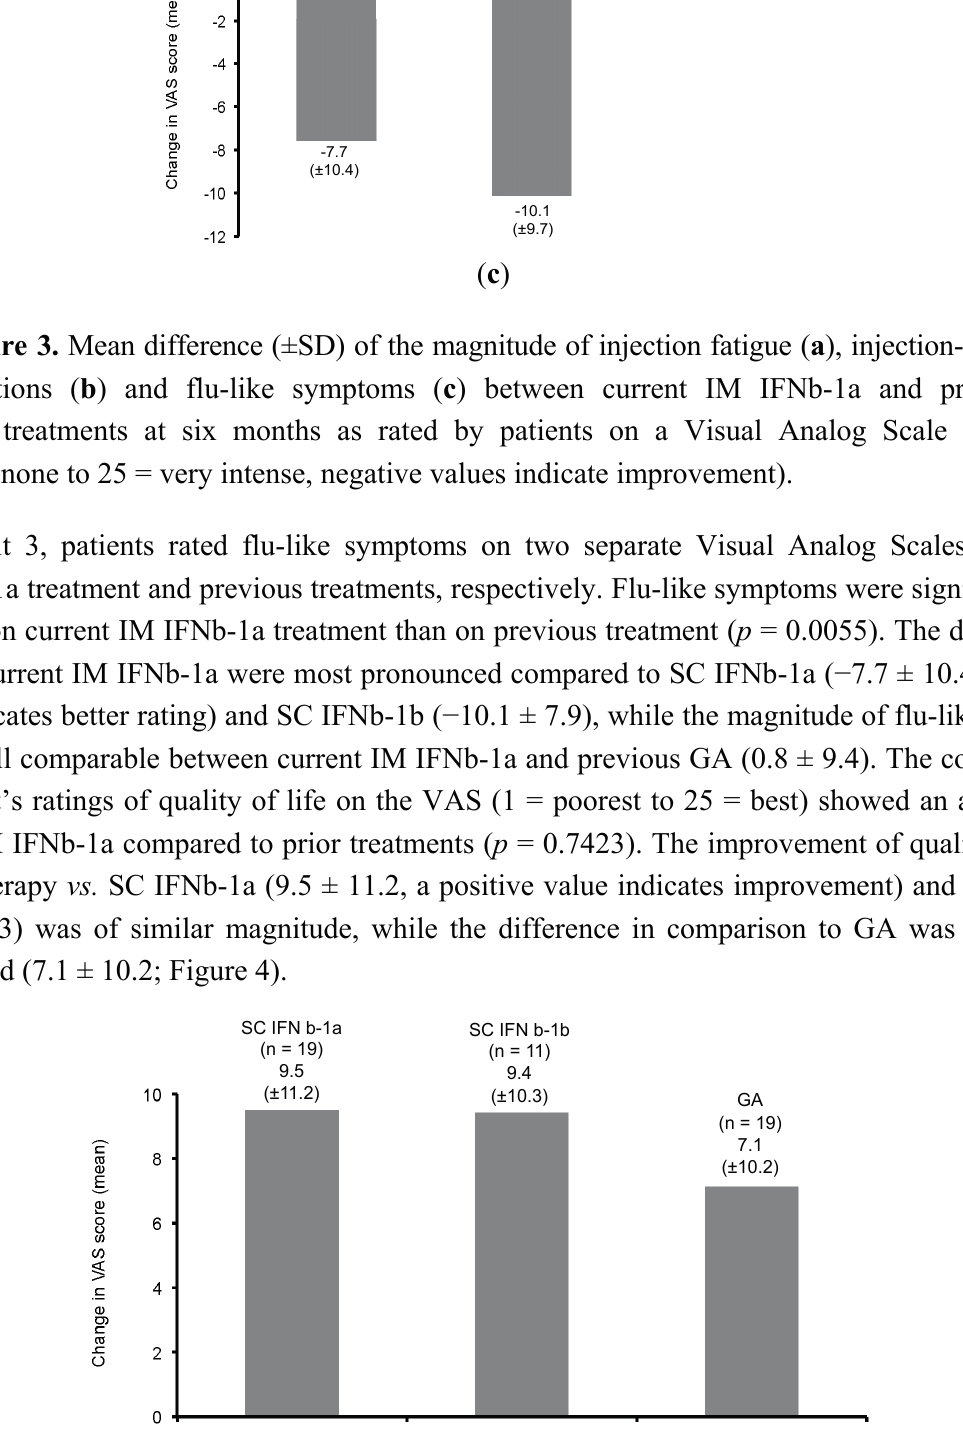
Figure 4. Mean difference of quality of life between current IM IFNb-1a and previous MS-treatments at six months as rated by the patients on a VAS (1 = poorest to 25 = best, positive values indicate